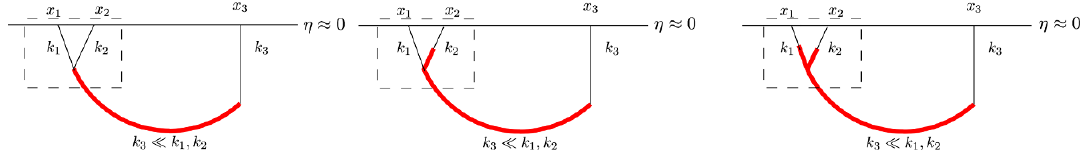
Figure 3 . From left to right: (a) Single Exchange Diagram, (b) Double Exchange Diagram, (c) Triple Exchange Diagram. Note that all these diagrams rely on mixing between the in(cid:13)aton (cid:13)uctuation and massive scalar in the (implicit) non-trivial background of rolling (cid:30) 0 ( t ).